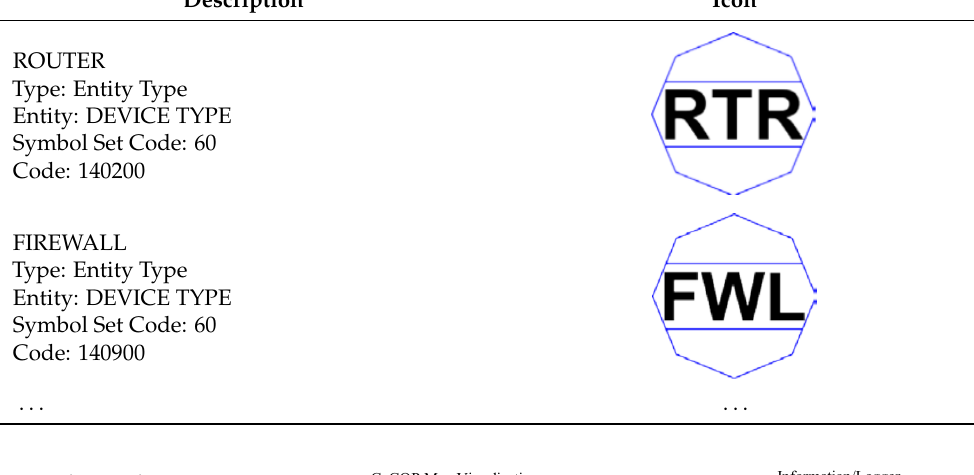
Figure 2. Cyberspace Symbol Components. Figure 3. CyCOP UI Structure. Table 7. Parts of Cyberspace Icons.